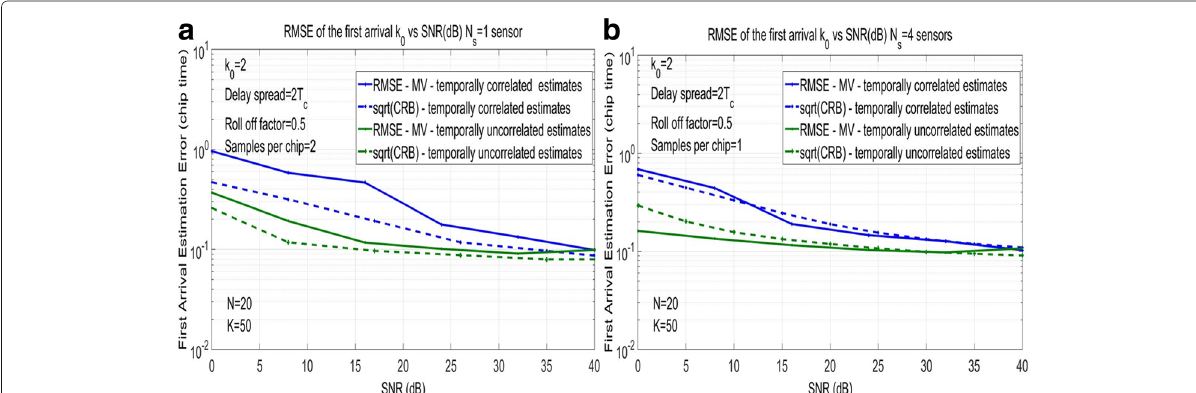
Fig. 13 Root mean square error of the first arriving path k 0 for different values of the SNR. Results are provided for different values of the temporal correlation α , and different configurations of the antenna array, a delay spread of 2 T c , 50 channel vector estimates available, and an angular spread of 5°. The roll-off factor set to 0.5. a Left: one sensor and the sampling rate set to twice the chip rate. b Right: one sensor and the sampling rate set to the chip